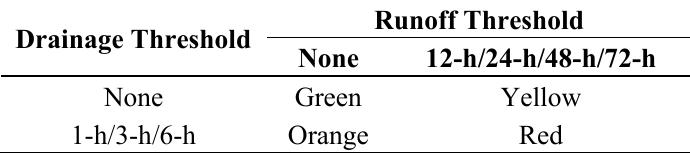
Table 2. Warning lights classified by the combination of exceeded rainfall